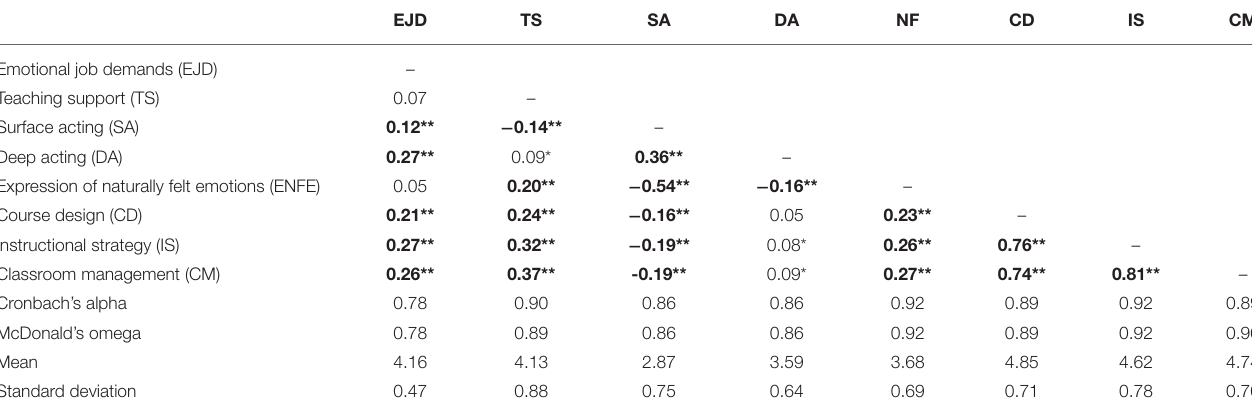
TABLE 1 | Correlations, descriptive statistics and internal consistency estimates of all standardized measures ( N = 643). EJD TS SA